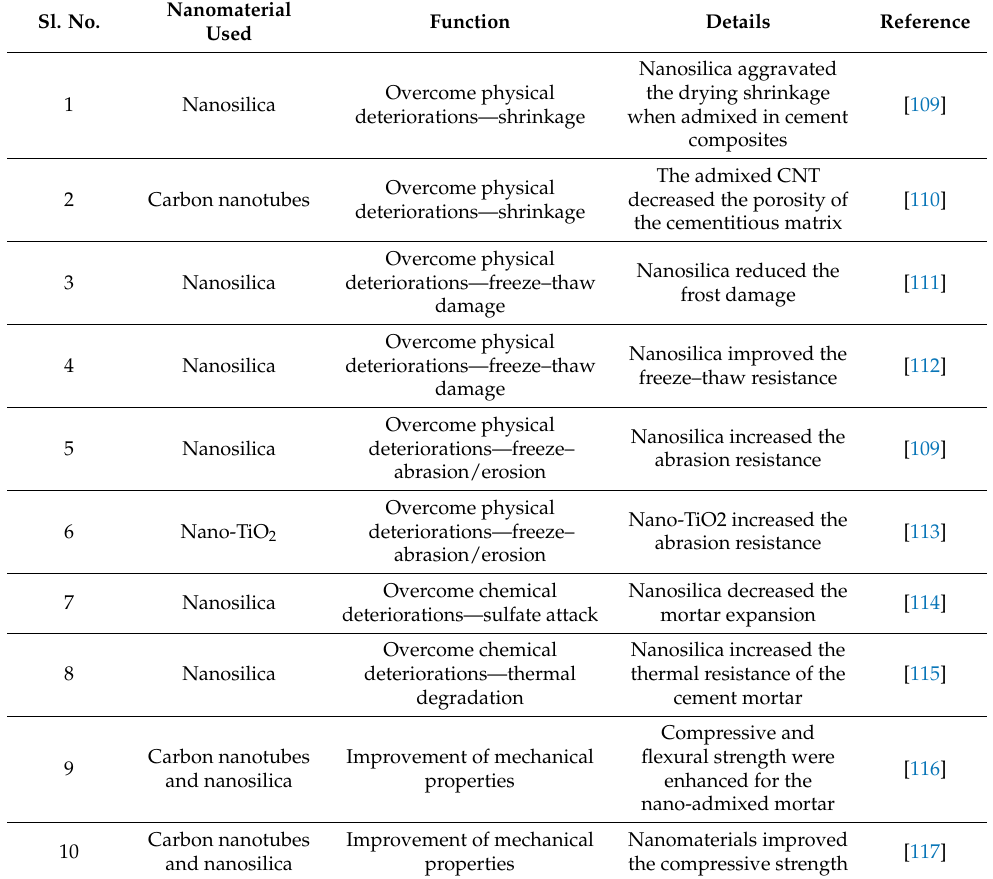
Table 2. Nanomaterial applications in